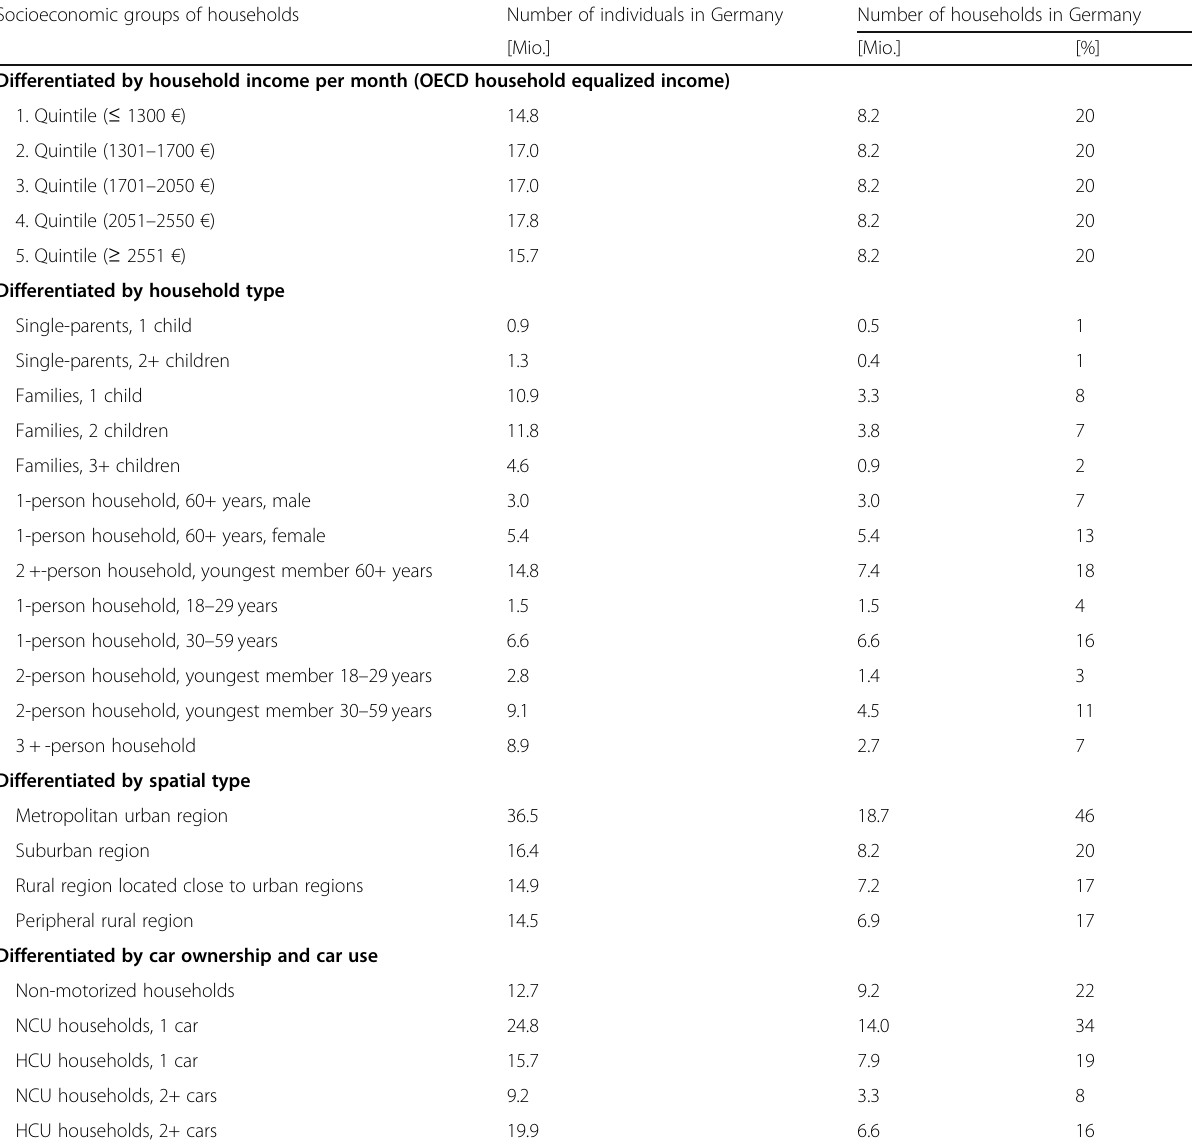
Table 2 Households and Individuals in the German Resident Population, Differentiated by Socioeconomic Group Socioeconomic groups of households Number of individuals in Germany Number of households in